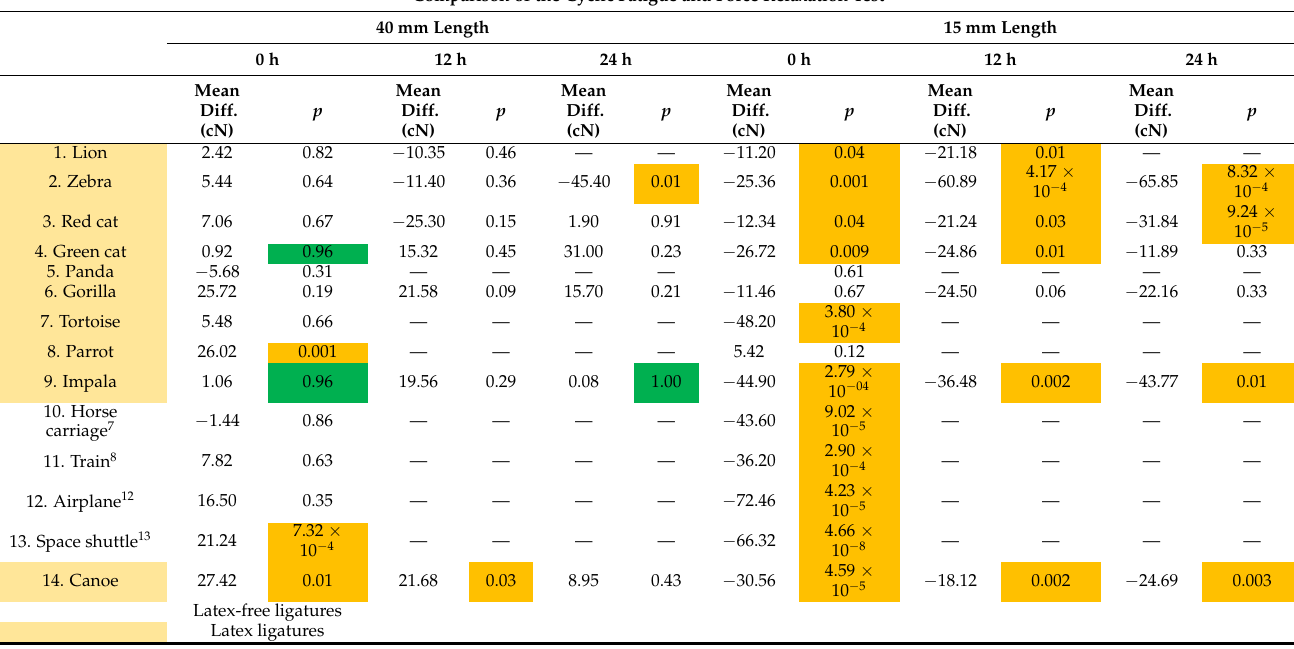
Table 5. The results of the cyclic fatigue and force relaxation were compared by a two-sample t-test. Orange color refers to the significant difference with 95% confidence interval and green color indicates changes less than